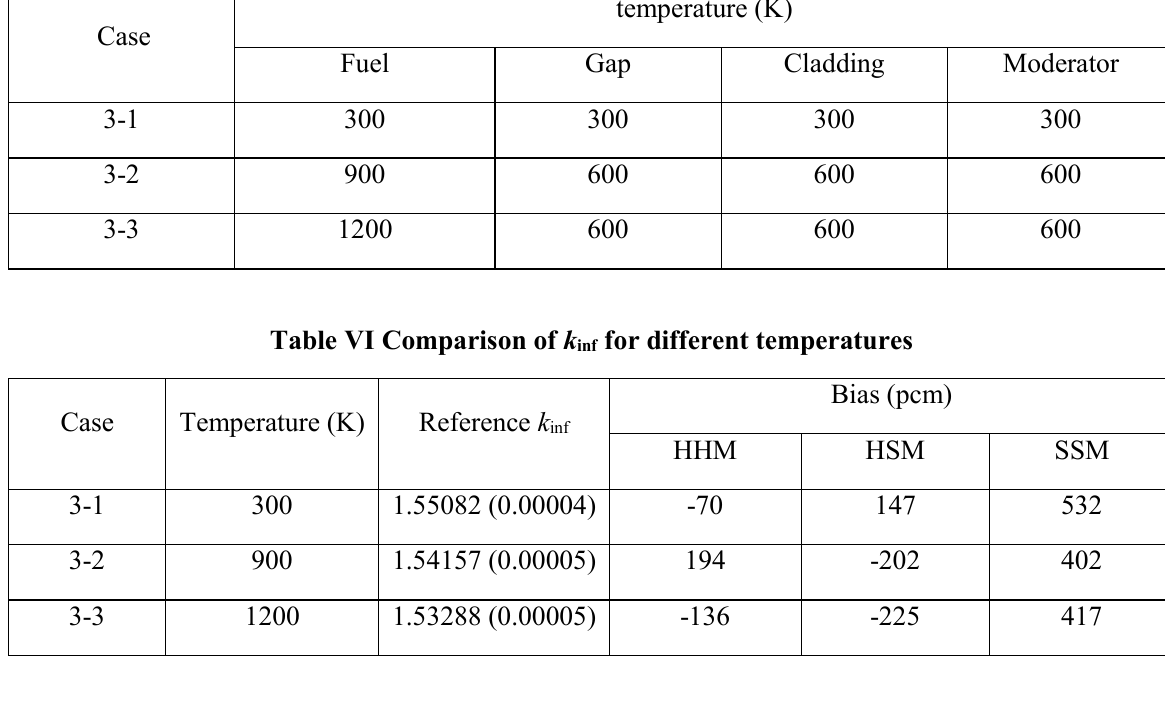
Table V Temperature of different materials